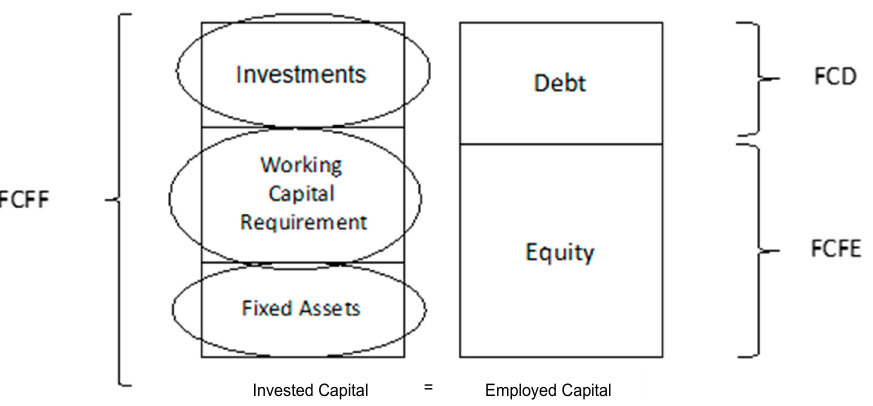
Figure 3. Analysis of a model based on free cash flows. Source: Own study on the basis of: [50]. On the basis of accrual streams, i.e., revenues and costs, which shape accounting ef- ficiency and are linked to the respective performance categories, a cash basis reflecting the cash flows corresponding to the respective decision areas can be constructed (Figure 4).